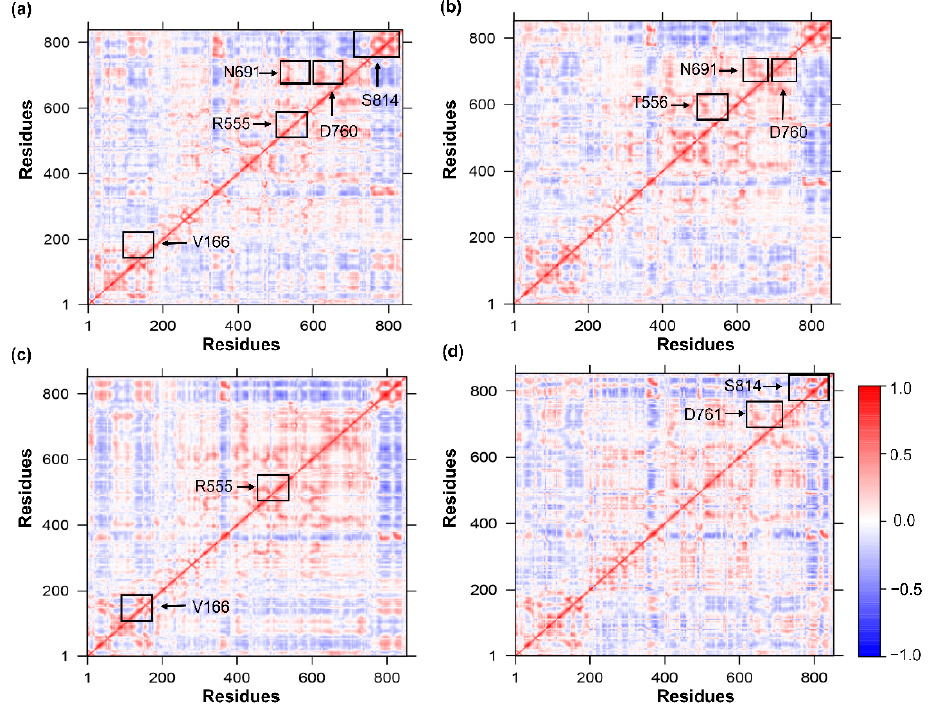
Figure 6. The DCCMs. The DCCM for ( a ) the apo-RdRp form and for the RdRp complex with ( b ) remdesivir, ( c ) ledipasvir, ( d ) paritaprevir. The color gradients represent a positive (red) and negative (blue) correlation.